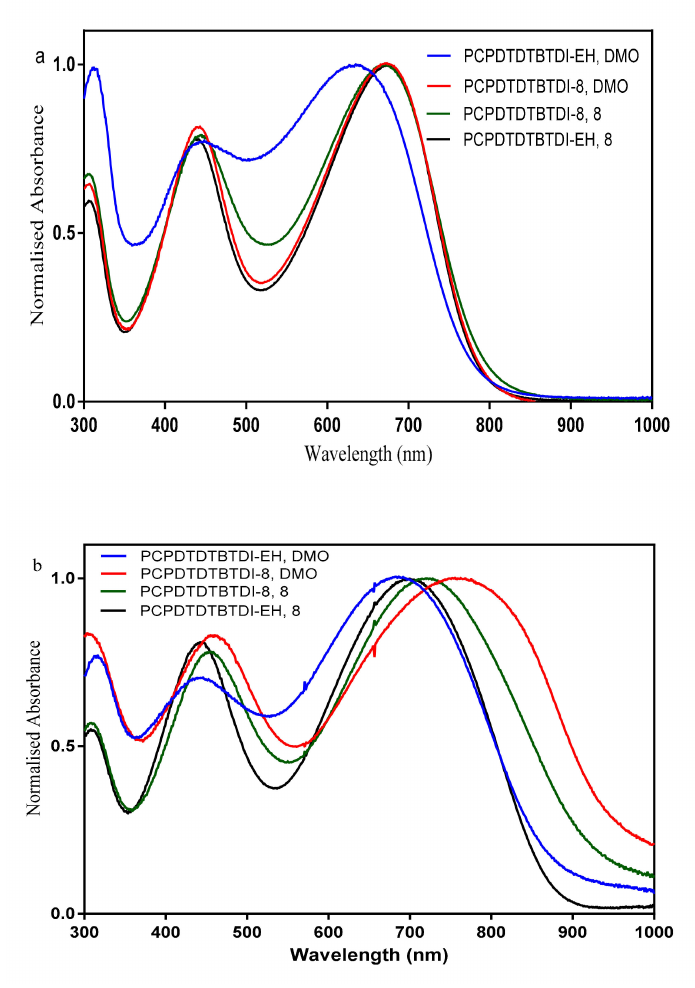
Figure 1. Normalized UV-VIS absorption spectra of PCPDTDTBTDI-EH, DMO, PCPDTDTBTDI-8,